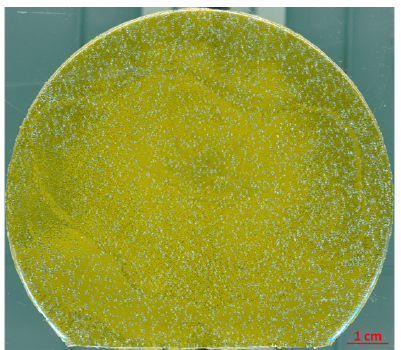
Figure 12. High resolution scan of free-standing 3C-SiC crystal grown by CS PVT on homoepitaxial seeding layer with a diameter of 92 mm and a thickness of 650 µm. With permission from